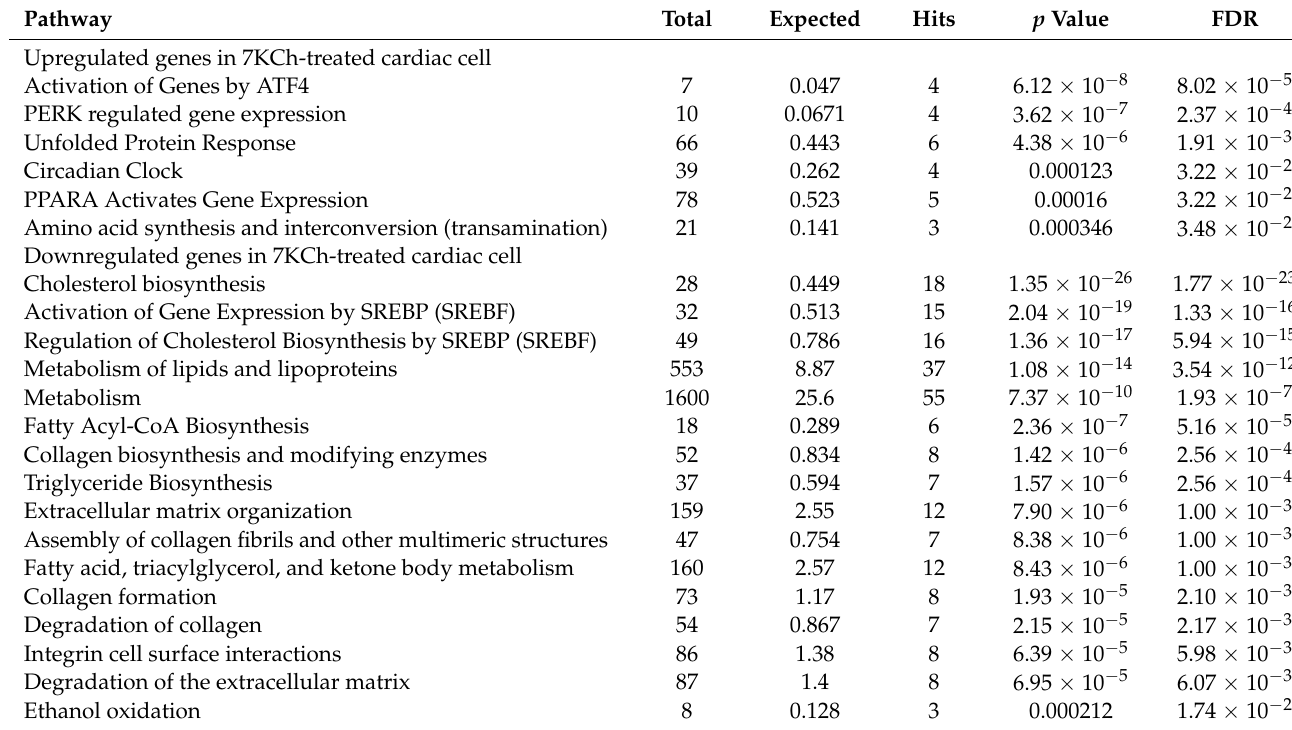
Table 1. Pathways with differentially upregulated and downregulated